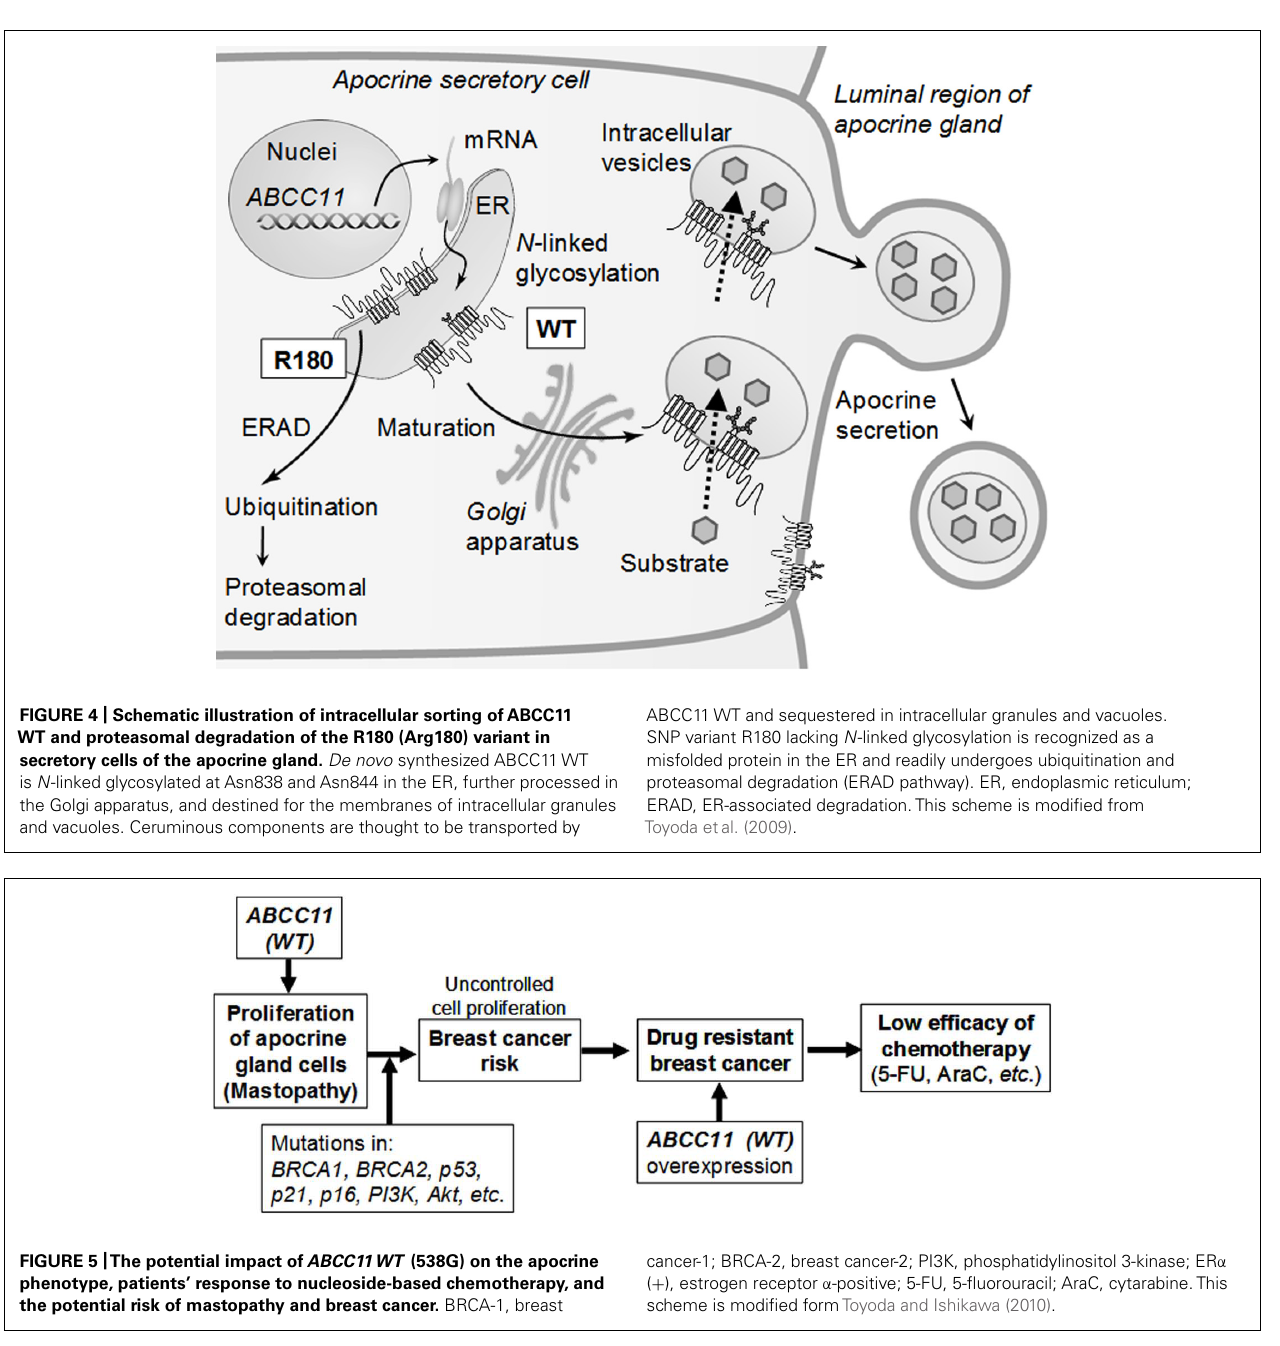
cancer-1; BRCA-2, breast cancer-2; PI3K, phosphatidylinositol 3-kinase; ER α ( + ), estrogen receptor α -positive; 5-FU, 5-fluorouracil; AraC, cytarabine.This scheme is modified formToyoda and Ishikawa